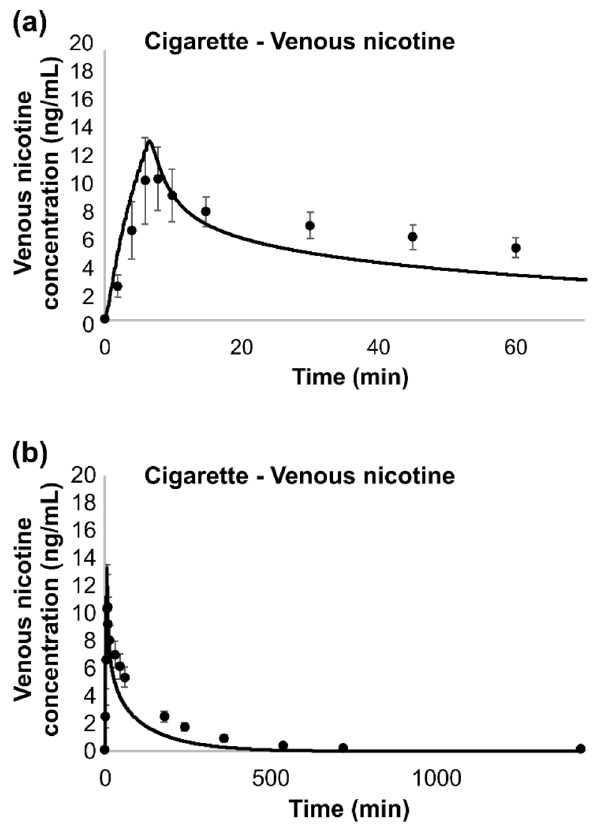
Figure 12. Model simulation of the single use of a conventional cigarette 27 : ( a ) expanded view of the first hour of ( b ) the overall simulation; points represent data from the study, along with associated standard deviations and solid lines represent simulation results.